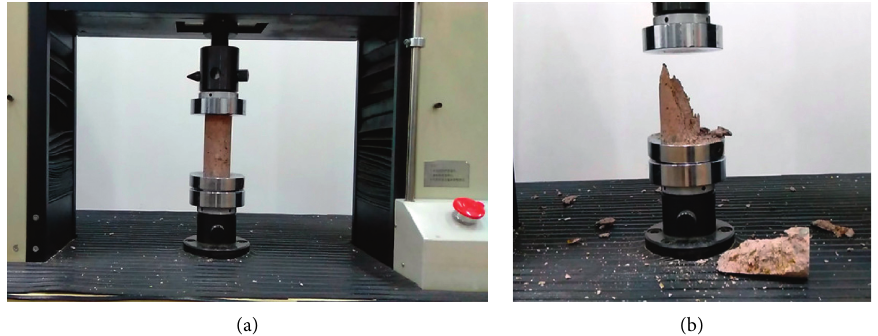
Figure 6: Uniaxial compression strength test. (a) The representative sample before the uniaxial compression test and (b) the representative sample after the uniaxial compression test.